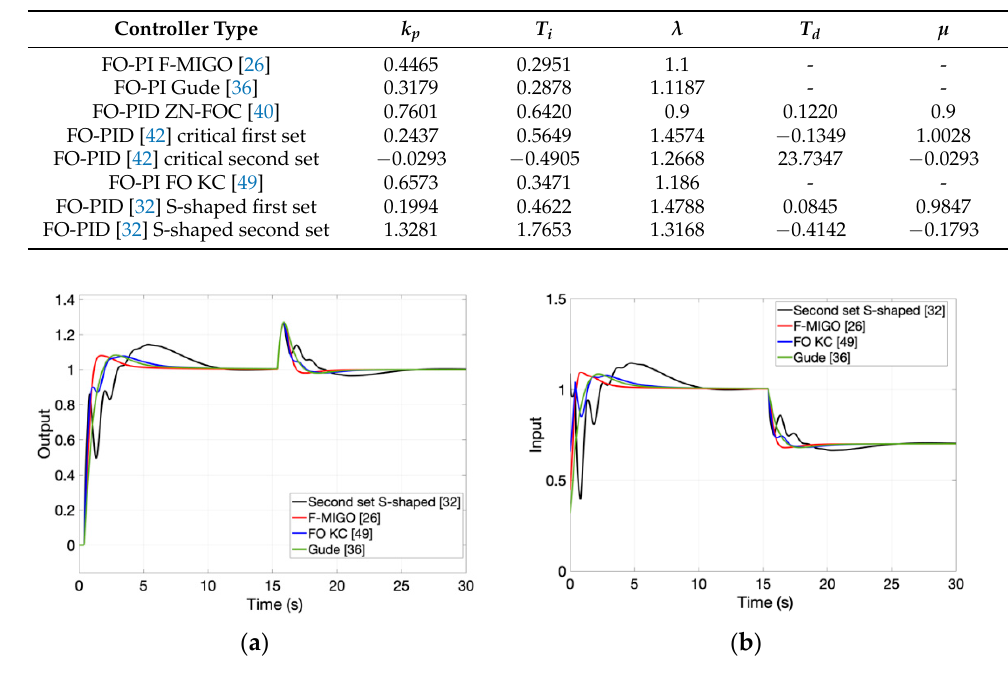
Figure 16. ( a ) Output signals for FO-PID control of delay-dominant process. ( b ) Input signals for FO-PID control of the delay-dominant process (controllers tuned according to [26,32,36] second set and [49]).